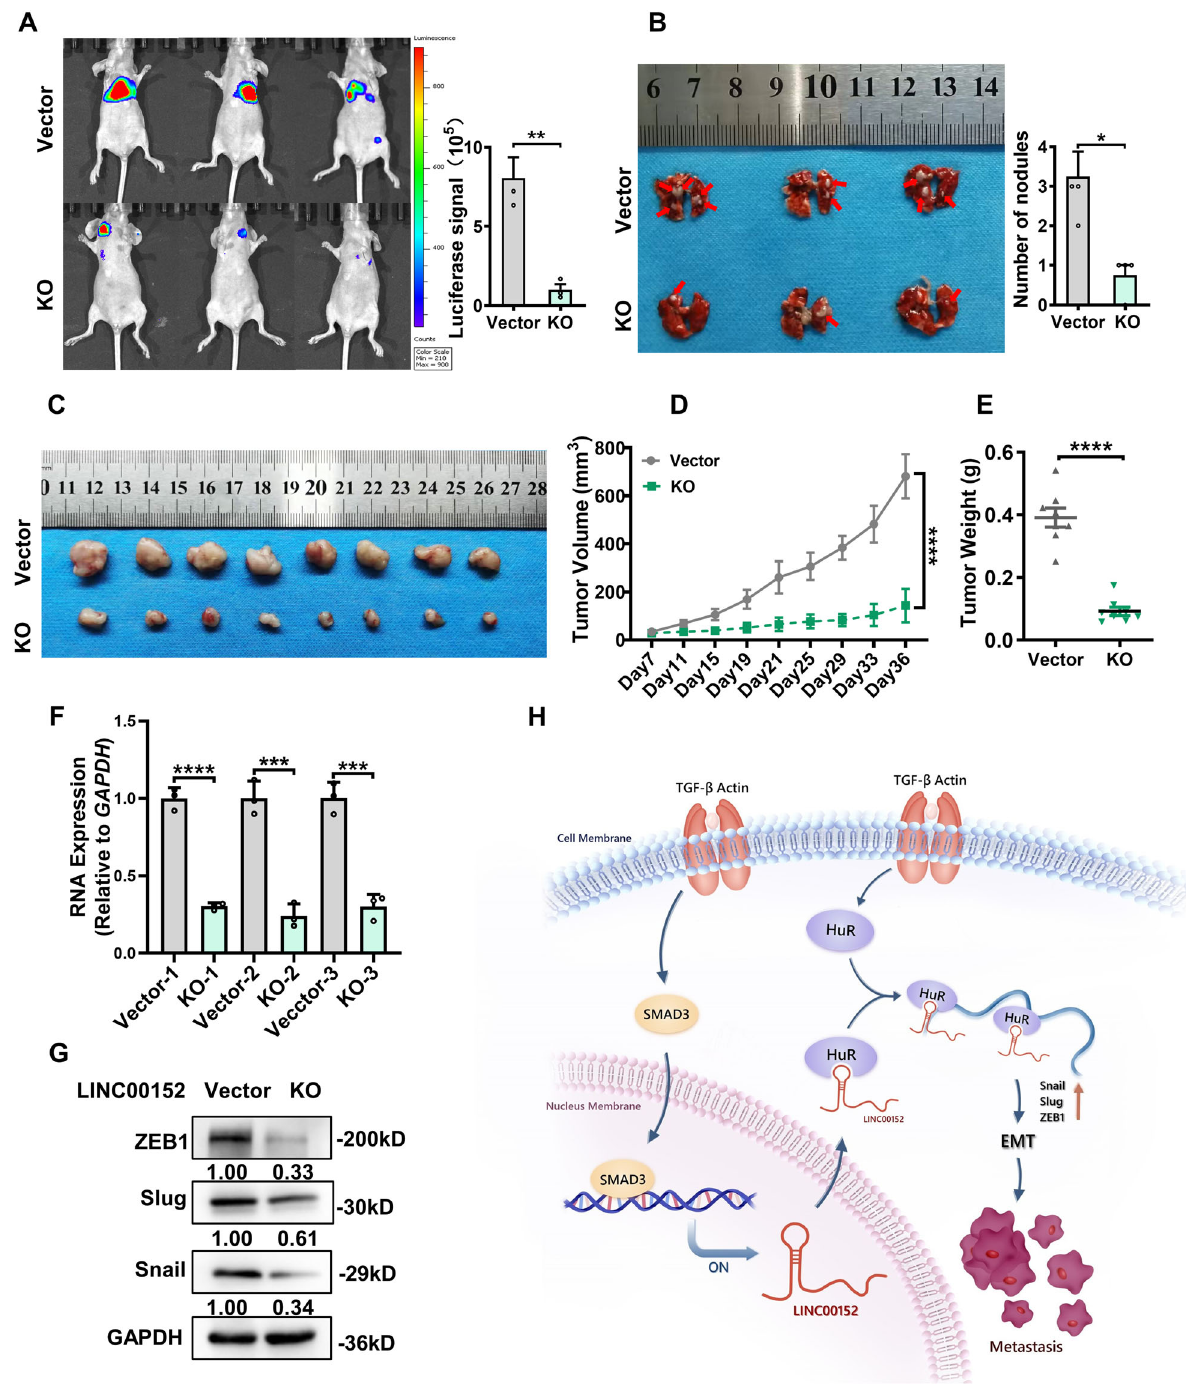
Fig. 8 Knocking out of LINC00152 by CRISPR/Cas9 system inhibits tumor growth and metastasis in vivo. A Vector control or LINC00152 KO cell were intravenously injected into nude mice. Luciferase signal intensities of each group were examined at 8 weeks, ( n = 3 per group). B Images of visible nodules on the lung surface. The number of lung metastatic nodules on each lung surface was quanti fi ed. C Images of subcutaneous tumor formation in nude mice at 5 weeks. Mice were injected with 5 × 10 6 Vector control or LINC00152 KO A549 cell. D , E Tumor volumes and tumor weights were measured for each group ( n = 8 per group). F RT-qPCR for LINC00152 expression in xenograft tumor tissues of Vector control or LINC00152 KO group. G Western blot for EMT associated genes (ZEB1, Snail, Slug) in xenograft tumor tissues of Vector control or LINC00152 KO group. H Schematic diagram of the molecular mechanism of regulation of LINC00152 expression and its function in LUAD. All the data have been presented as the mean ± SD of three independent experiments (* p < 0.05; ** p < 0.01; **** p < 0.0001. Student ’ s t -test). Western blot assay USA). BCATM protein analysis kit (Thermo Fisher Scienti fi c) was used to The proteins were extracted using Radio Immunoprecipitation Assay Buffer quantify the proteins. 50 μ g protein was separate using a 10% sodium (Beyotime Biotechnology, Haimen, China) with protease inhibitor (Selleck, dodecyl sulfate-polyacrylamide gel electrophoresis and transferred to the Cell Death and Disease (2022)